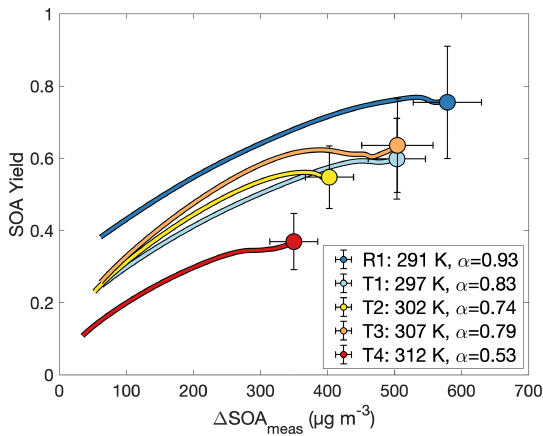
Figure 7. Secondary organic aerosol yields as a function of organic aerosol formed for experiments R1 and T1–T4, all run at different temperatures and otherwise similar initial conditions. The value of α is from a fit to a two-parameter fit to Eq. (3) ( K om is not shown). Data are shown only after 30min into the experiment to minimize the error from noise at the beginning of